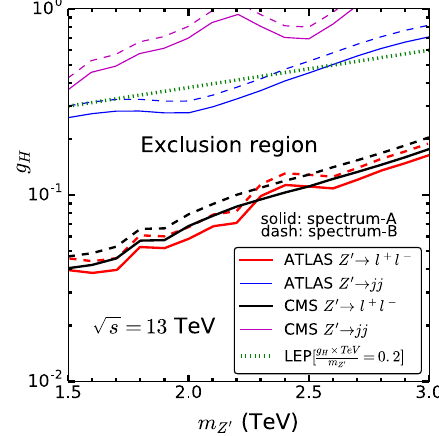
Fig. 1 The Z (cid:2) constraints for G2HDM inferred from the latest ATLAS and CMS 13TeV results. The solid lines denote Spectrum A, while the dashed lines refer to Spectrum B. The main differences between the two scenarios are the branching fractions of Z (cid:2) into the SM quarks and leptons, as shown in Table